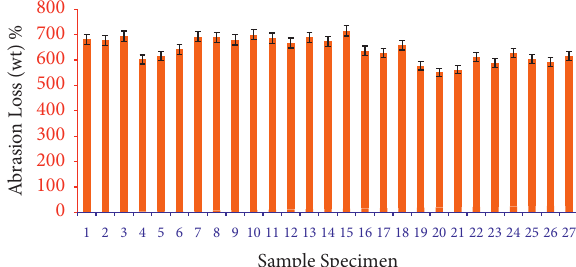
Figure 4: Impact of fiber parameters on abrasion loss.